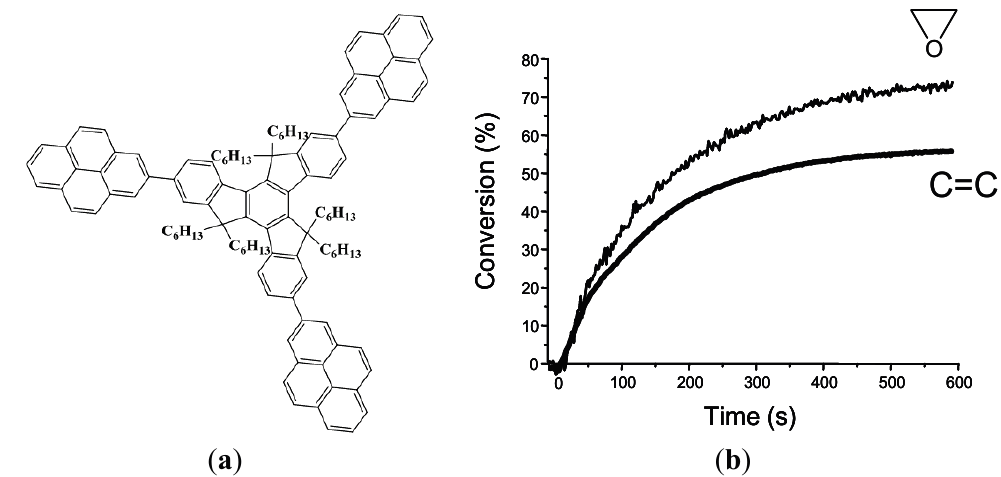
Figure 2. Structure of ( a ) T_1 and ( b ) conversion profiles for the epoxy and acrylate double bond functions for an EPOX/TMPTA blend (50%/50% w / w ) upon halogen lamp; irradiation under air in the presence of T_1/(TMS) 3 Si–H/Ph 2 I + (0.2%/3%/2% w / w / w ).